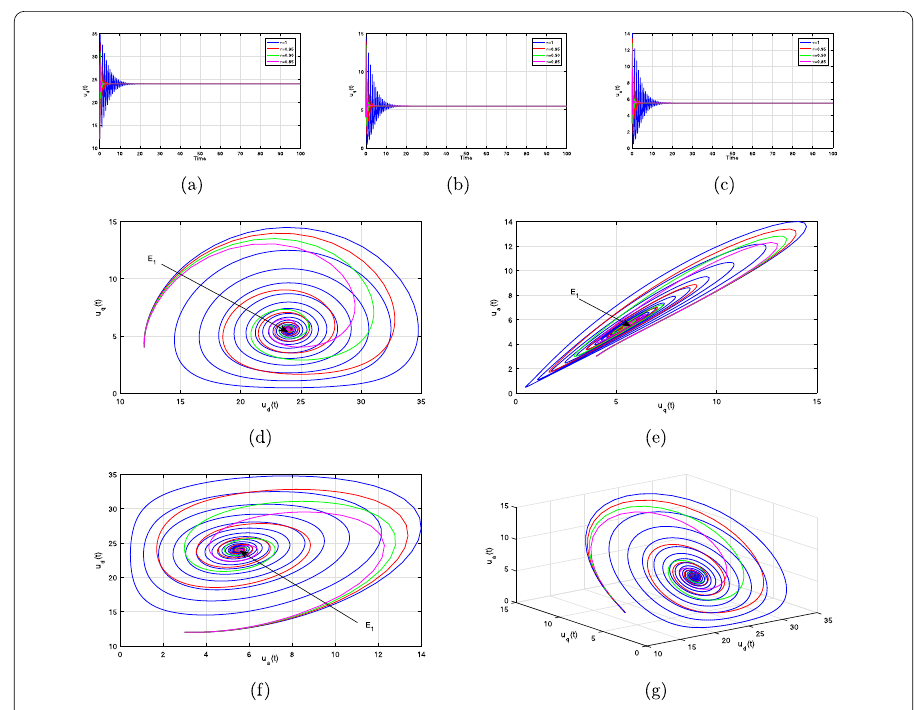
Figure 4 Simulations of Example 3 for time-fractional brushless DC motor (10) in the Liouville–Caputo